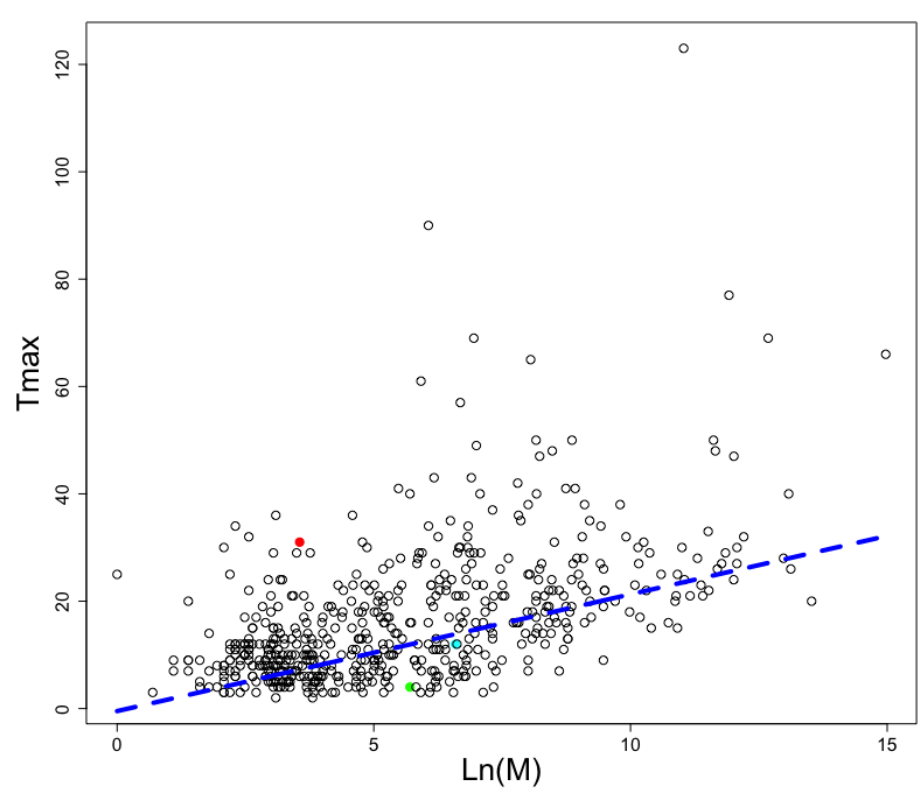
Figure 5. Longevities and weights in animals. The adjusted linear relationship (blue broken line) for animals reported in AnAge database. The naked mole rat (red circle), the common cuy (cyan circle), and the common rat (green circle) are shown as examples of long-, average-, and low-lived rodents. The y-axis represents the maximum number of years an animal is reported to live, and the x-axis, Log(M), represents the natural logarithmic value of the animal weight in grams.